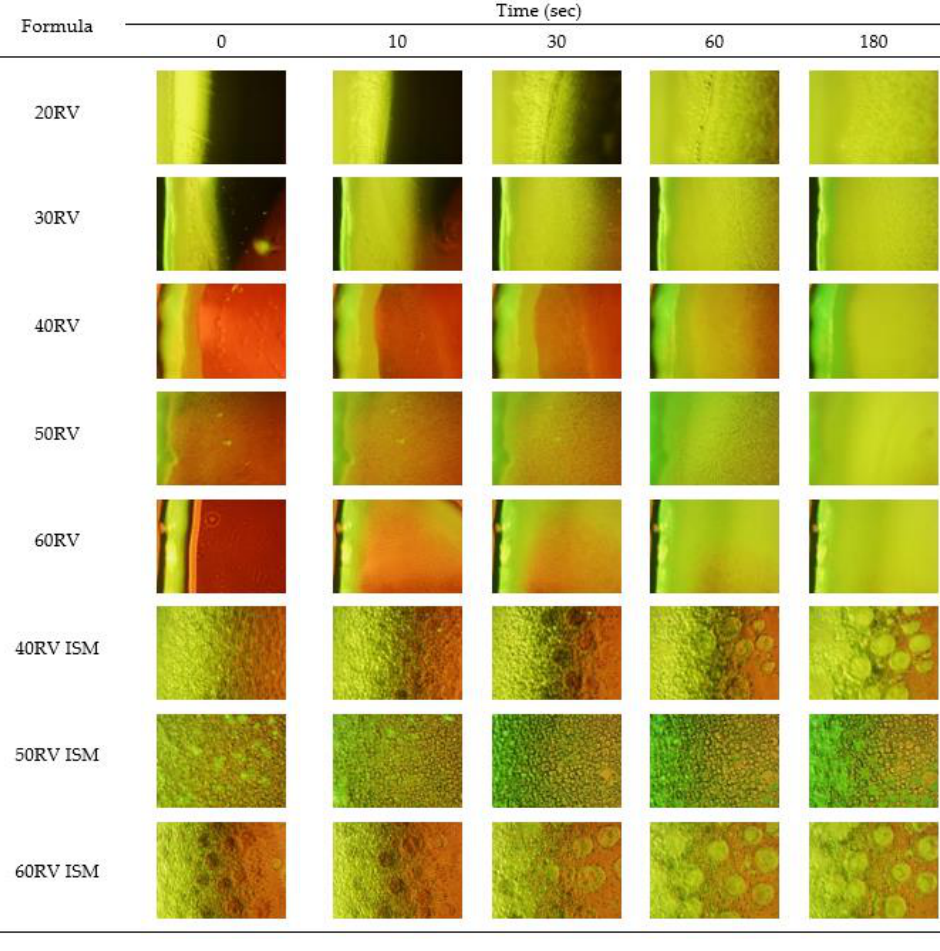
Figure 4. Microscopic transformation of vancomycin HCl-loaded ISG containing 20 – 60% ( w / w ) rosin and ISM containing 40 – 60% rosin under the inverted microscope using 0.003% w / w sodium fluorescence in agarose gel as the gum cavity simulation system.